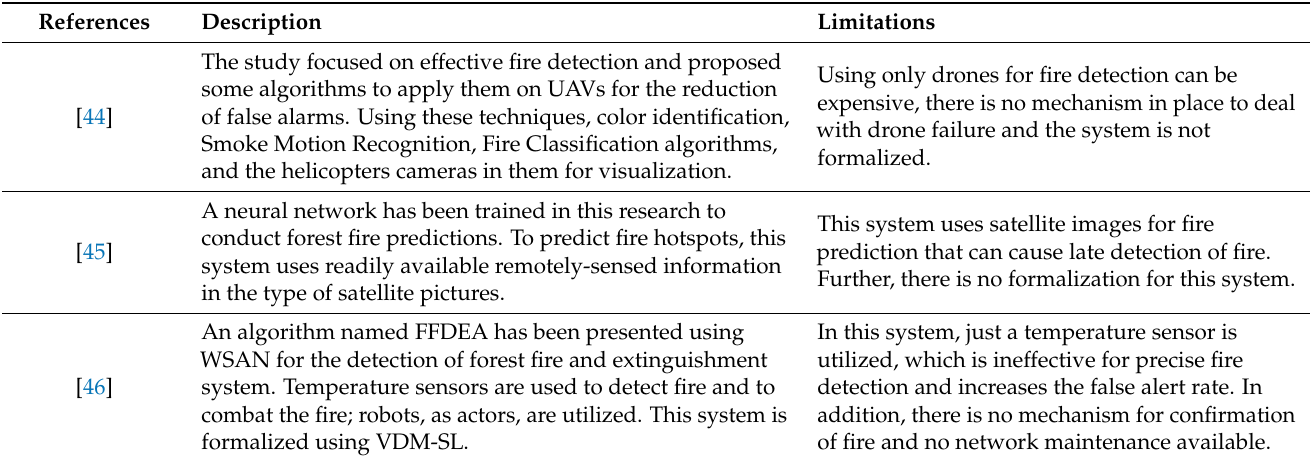
Table 1. Most relevant existing studies with